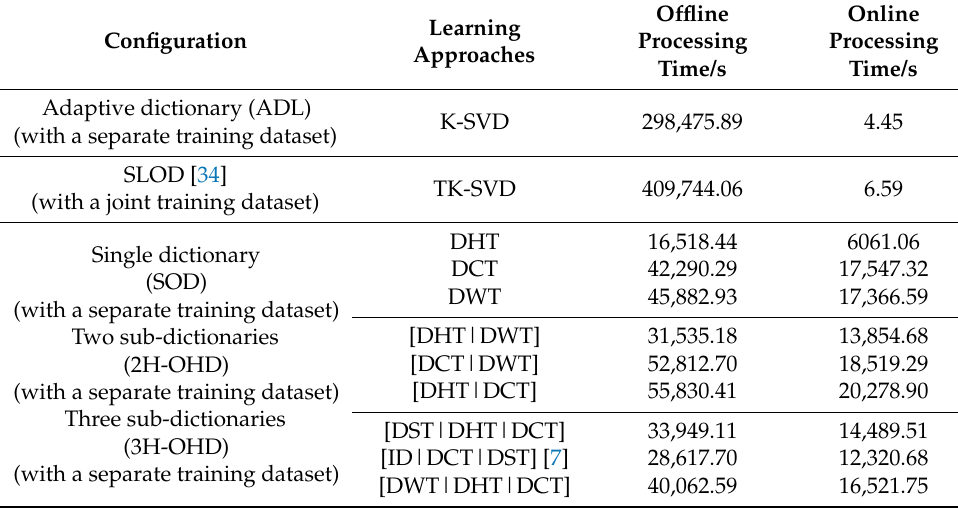
Table 5. CPU time (in sec.) of fixed and adaptive supervised dictionary learning.